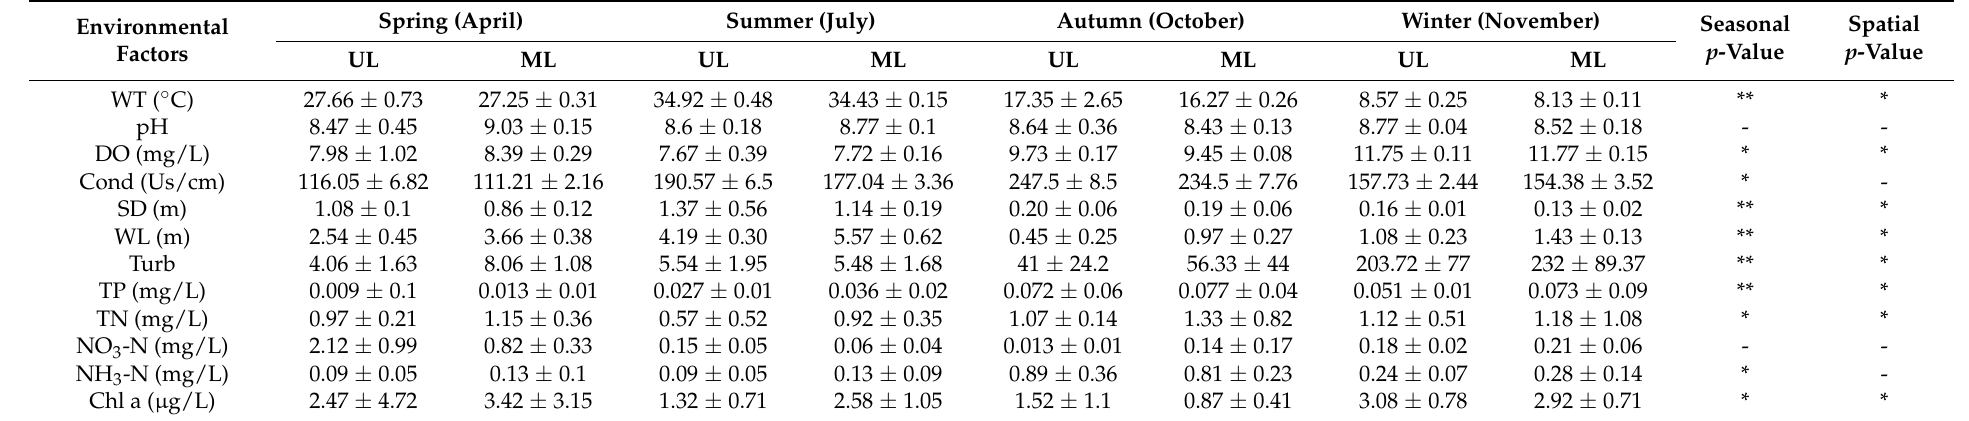
Table 1. The average value of environmental parameters of Shengjin